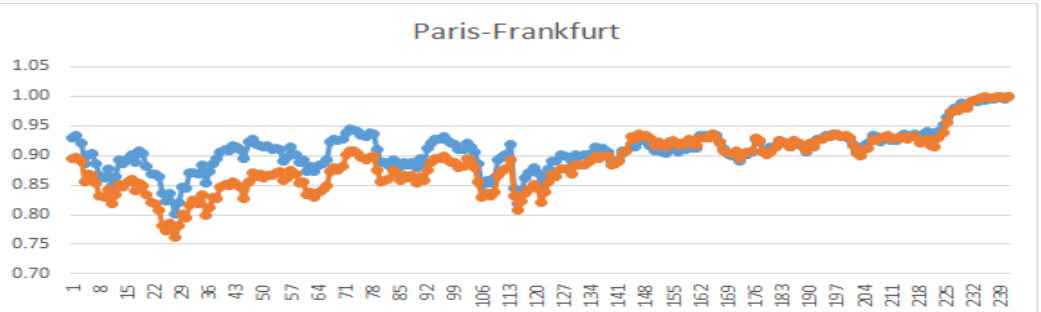
Figure 6. Comparison of graphs of normalized prices for Frankfurt and Paris; S ( Paris,Frankfurt ) =